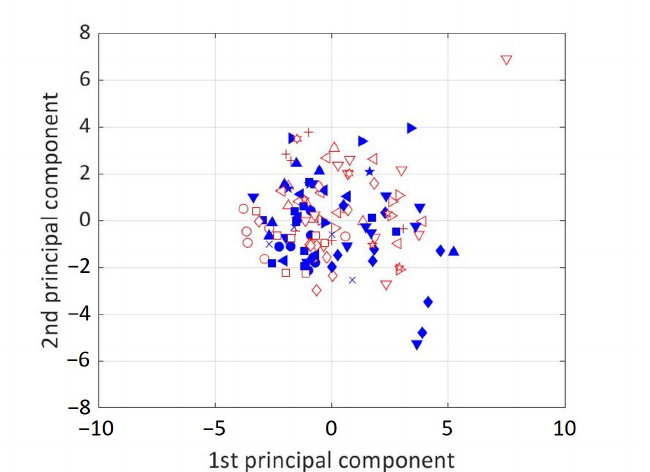
Figure 6. Distribution of the principal component analysis scores of each subject. Markers of the same shape denote a single subject. Colors stand for the slow (blue-filled) and fast (red hollow)